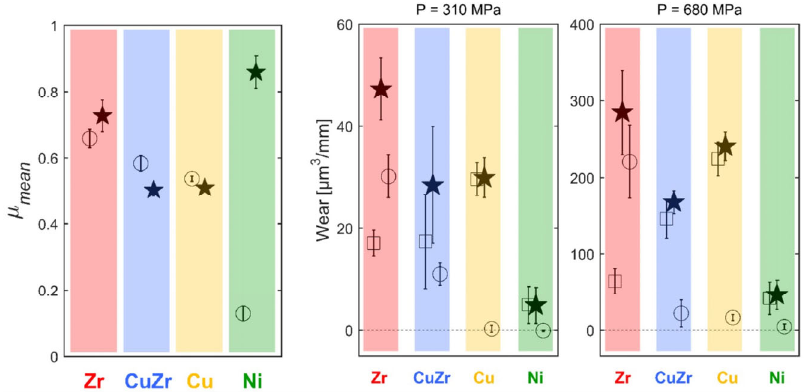
Fig. 36 Mean friction coefficients and wear index of the tested four BMGs [582]. Reproduced with permission from Ref. [582], © Elsevier Ltd.,